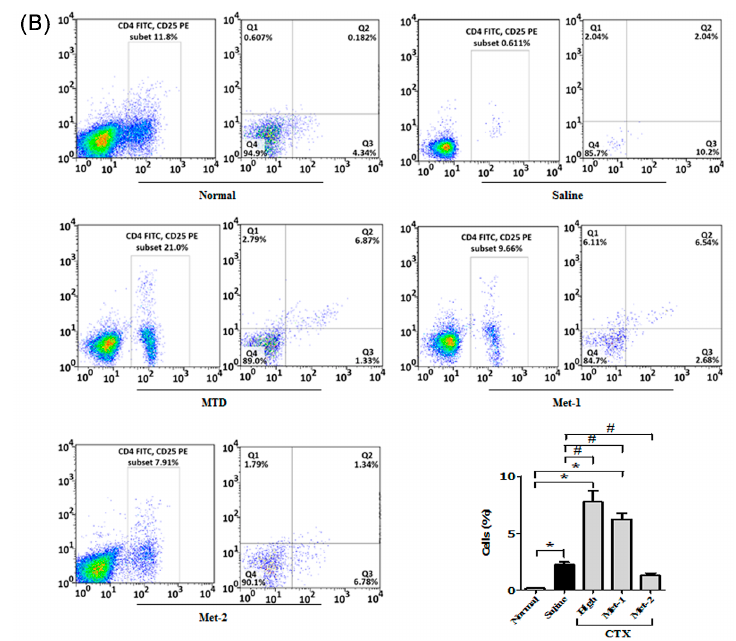
Figure 6. CD4 + /CD25 + FoxP3 cells in blood ( A ) and spleen ( B ) from each group at the end of the observation period were measured by flow cytometry analysis. Fresh blood was collected in EDTA tubes and flow cytometry analysis was performed as described previously. “*” versus normal group and “#” versus saline group. * p < 0.05, # p < 0.05.